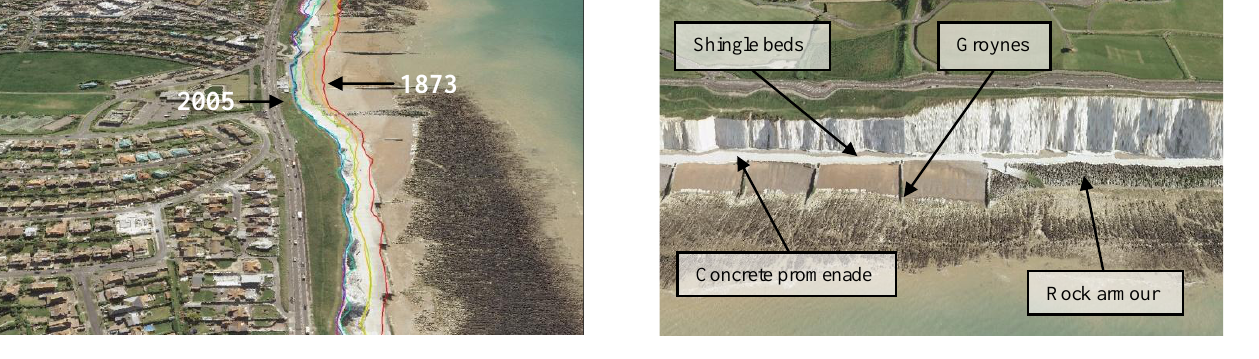
Fig. 7. Examples of protection measures along the coast.